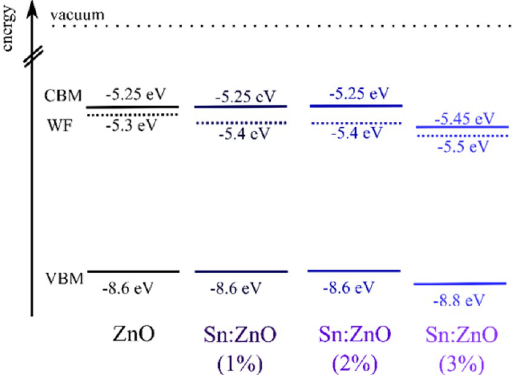
Figure 4. Energetic landscape in ZnO-NWs with doping concentrations of 0–3 mol% in the growth solution. Work function (WF) and valence band maxima (VBM) are obtained from UPS and conduction band minima (CBM) by substracting the absorption onset (energy band gap) from the